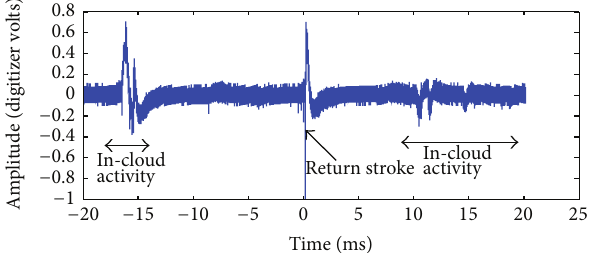
Figure 5: An example of electric field record of positive return stroke on November 23, 2012, 4:16:03 pm with both preceding and following in-cloud activities.